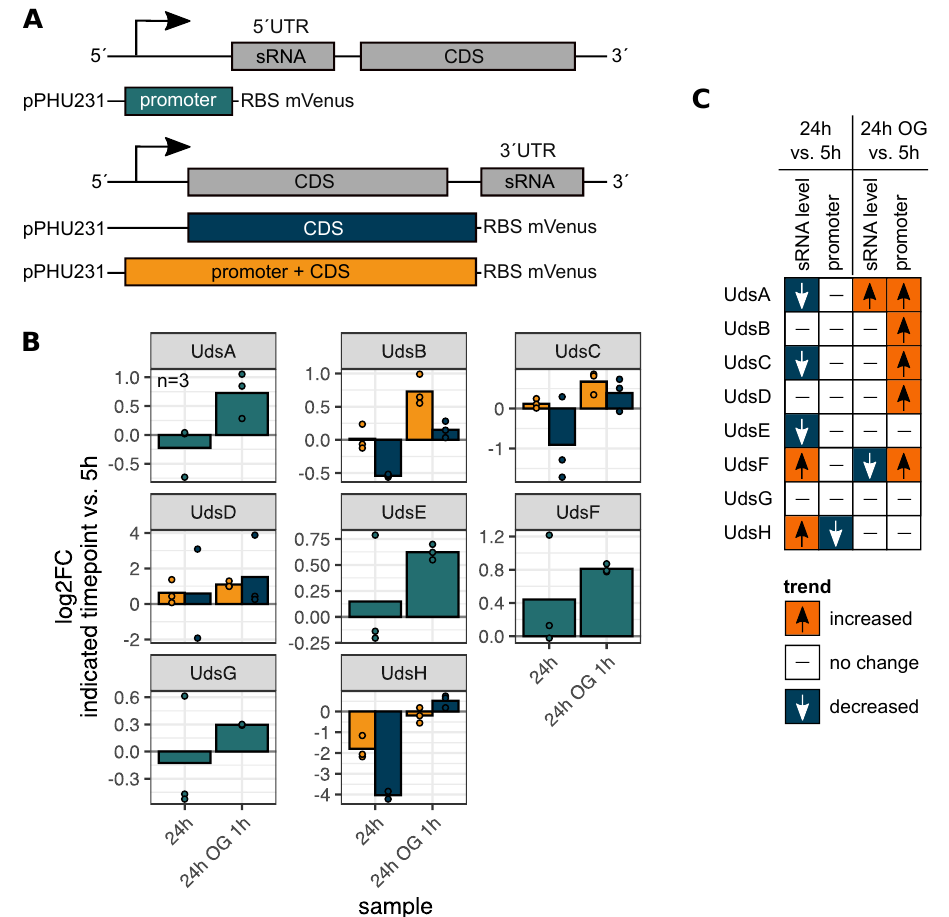
Figure 5. The UTR-derived sRNA promoter activity is growth phase dependent but does not represent the observed sRNA level in all cases. ( A ) Overview of the transcriptional promoter fusions used in this study. ( B ) The plasmids were conjugated in the wild type strain and the fluorescence intensity was measured after 5h, 24h and from the outgrowth culture. x-axis: sample. y-axis: log 2 fold change of the indicated timepoint vs. signal during exponential growth phase (5h). Green: promoter sequence. Blue: coding sequence (CDS). Yellow: promoter + coding sequence. n = 3. Every dot represents the mean value of two technical replicates. Signals F/OD 660 are shown in Figure S6. ( C ) Classification of the sRNA level and the promoter activity, based on northern blot data and fluorescence intensities. Red: increased compared to the exponential phase. Blue: decreased compared to the exponential phase. White with horizontal dash: no